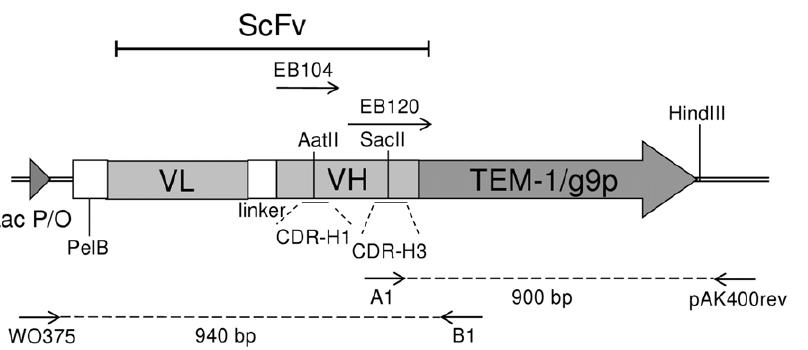
Figure 2. Target of mutagenesis. In the CDR-H1 loop mutagenesis and VH-gene incorporation scFv gene was fused to gene 9-protein (g9p) of the filamentous phage. In the CDR-H3 loop mutagenesis scFv was fused in-frame to b -lactamase (TEM-1). EB104 was the mutagenesis primer in the CDR- H1 and EB120 in CDR-H3 mutagenesis, respectively. The primer pairs WO375-B1 and A1-pAK400rev were used in the analysis of transformants of the CDR-H3 mutagenesis. (ScFv) Single-chain variable fragment, (VL) immunoglobulin variable light domain gene, (VH) immunoglobulin variable heavy domain gene, (PelB) signal sequence for periplasmic excretion and (Lac P/O) Lac promoter.